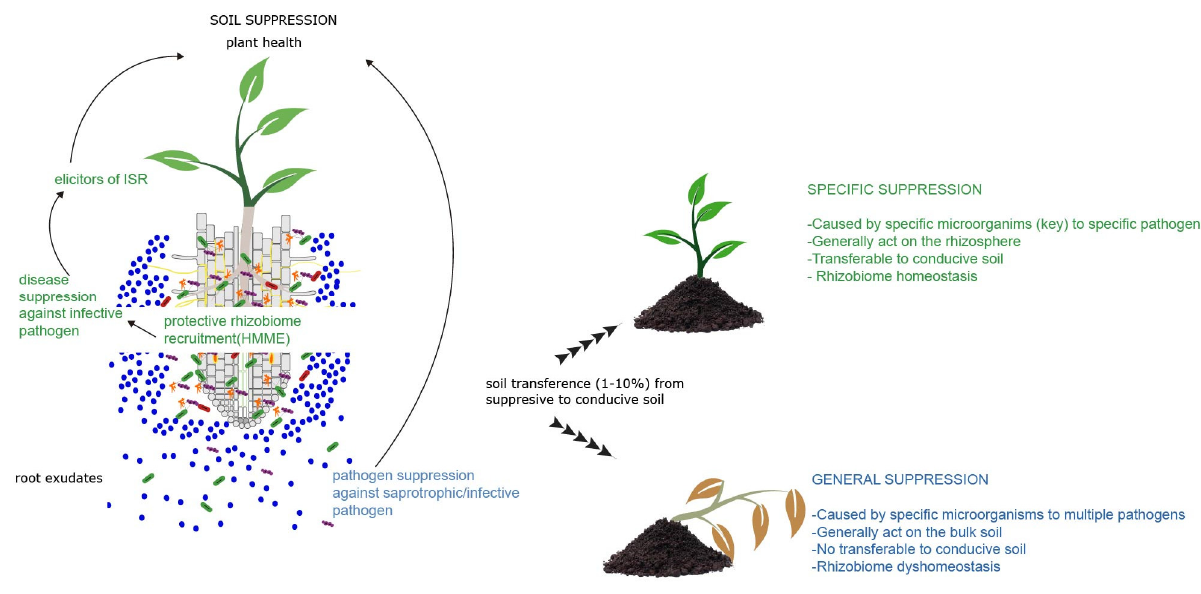
Figure 1. Schematic representation of specific (green letters) and general suppressiveness (blue letters). Specific suppression is limited to a particular pathogen and is mediated by one or a few specific microorganisms. Moreover, it is potentially transferable to conducive or non-suppressive soil. General suppression occurs as a general antagonistic effect exerted by the total soil microbial biomass in the bulk soil against a broad spectrum of pathogens (mainly in saprotrophic phase). General suppression is not transferable between soils.